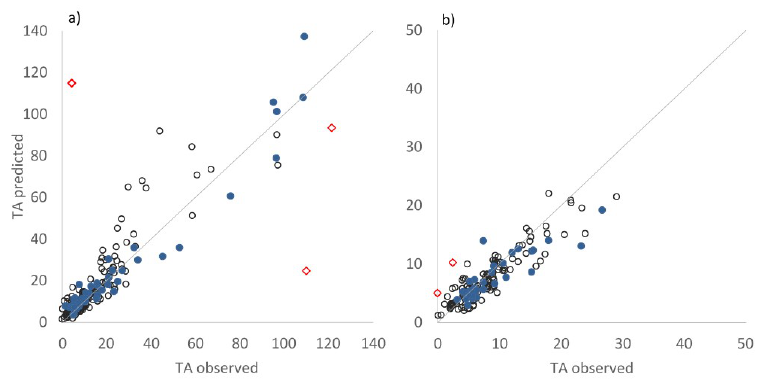
Fig. 5. Predicted titratable acidity (TA, cmol(+) kg -1 ) modelled using a) pH, soil organic carbon (SOC, %) and pH x SOC as predictors for whole data and b) pH, clay and SOC for mineral soils plotted against observed TA (cmol(+) kg -1 ). Open circles represent the results of the calibration data and blue circles represent the validation data. Data points excluded from the regression analysis as outliers are marked with red squares.